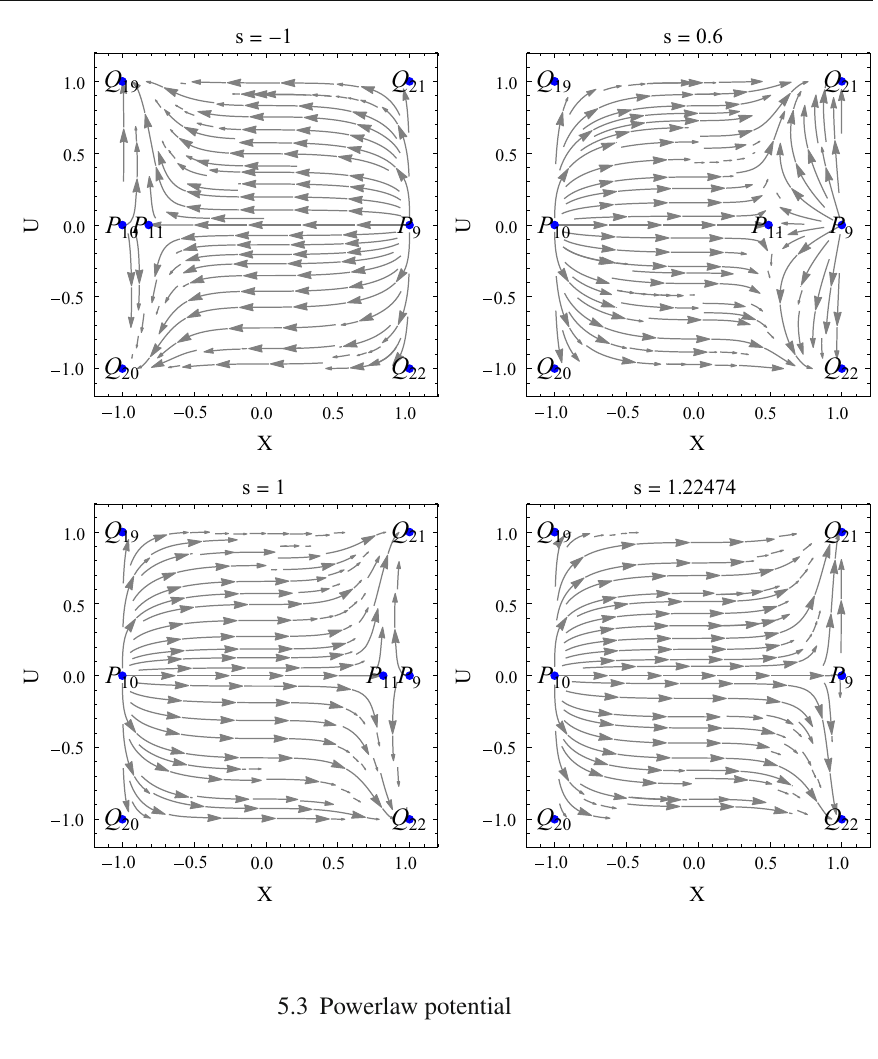
Fig. 7 Compact phase portrait of (212), (213) for different choices of the parameter